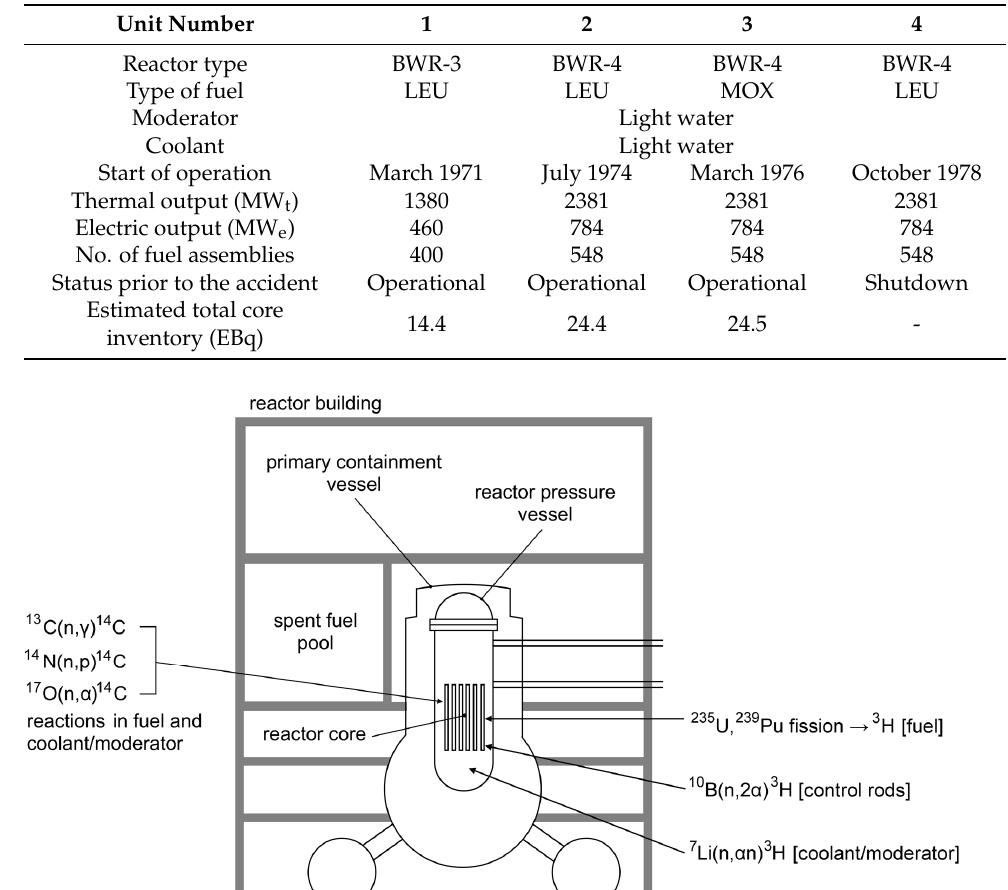
Table 1. Basic parameters of the FDNPP boiling water reactors [36].